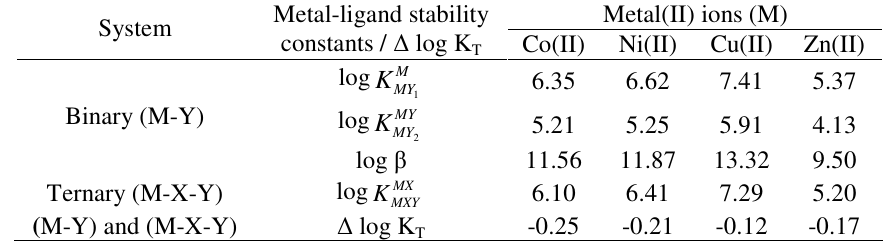
Table 2. Metal-ligand stability constants of binary (M-Y), ternary (M-X-Y) systems and ∆ log K values in 75: 25 % (v/v) 1,4-dioxne-water medium at 27 ± 0.5 o C and µ = 0.1M